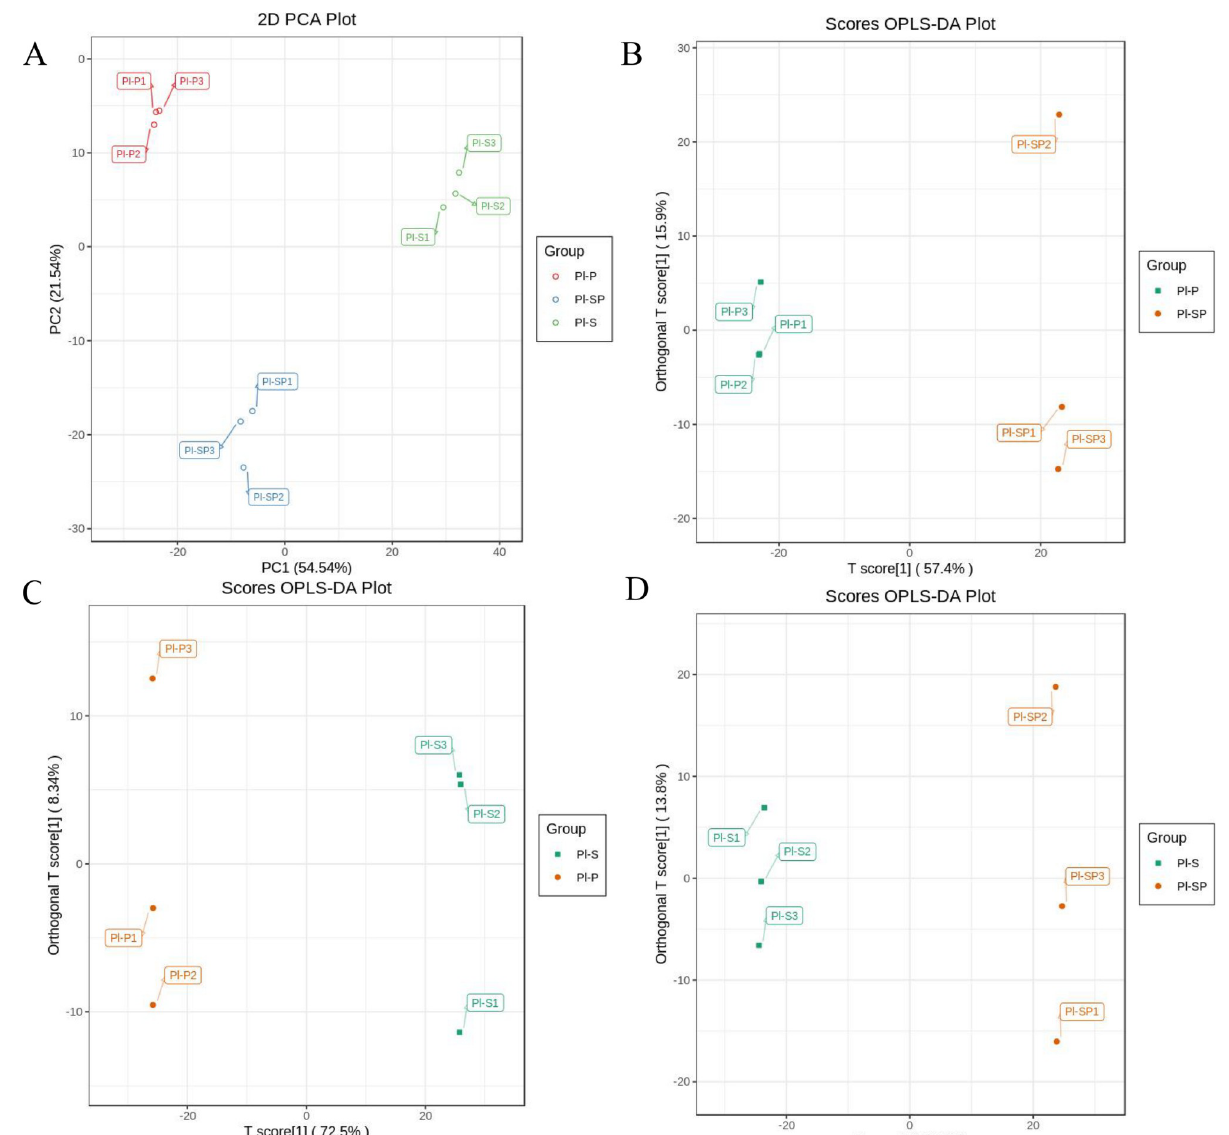
Fig 4. The identified metabolites analysis. A. PCA score plot. B-D. OPLS-DA model plots for the comparison groups Pl-P vs. Pl-SP (B), Pl-S vs. Pl-P (C), Pl-S vs. Pl-SP (D). and S2 Table), and 410 DAMs between Pl-S and Pl-SP (96 up-regulated, 314 down-regulated) (Fig 5B and S3 Table). The differential metabolites for the comparison groups of Pl-P vs. Pl-SP and Pl-S vs. Pl-SP were classified into 32 and 34 different categories (S4 Table). Significantly, the number of flavonoids and phenolic acids DAMs was well ahead of other categories. Besides, most flavonoids metabolites, including flavonols, chalcones, flavonoid, dihydroflavonol and dihydroflavone, were down-regulated in Pl-SP compared with Pl-S. Meanwhile, 126 common differential metabolites were identified in all the composition groups (Fig 5C) and were divided into 11 classes, including 45 flavonoids, 27 phenolic acids, 9 alkaloids, 8 lipids, 7 nucleotides and derivatives, 7 terpenoids, 3 tannins, 2 lignans and coumarins, and 4 others (Fig 5D).